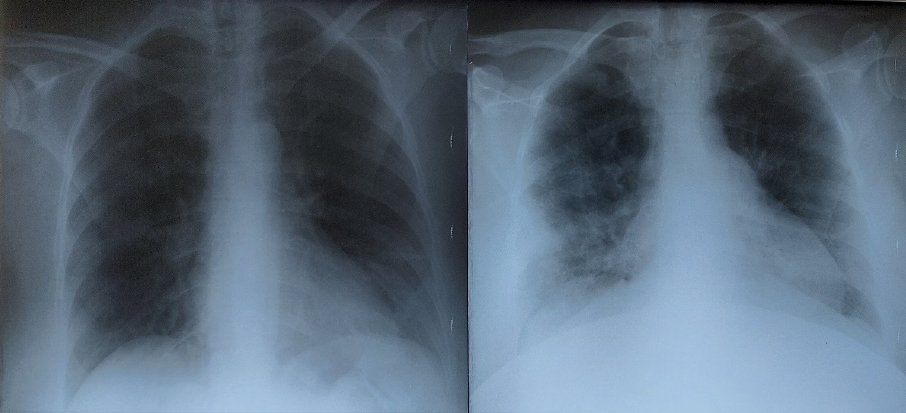
Figure 3. On the left, upon admission, Brixia A score 1, qSOFA score 1. On the right, three days later, Brixia H score 8, qSOFA score 1 (respiratory rate over 22 breaths per minute). Patient in the autumn group.